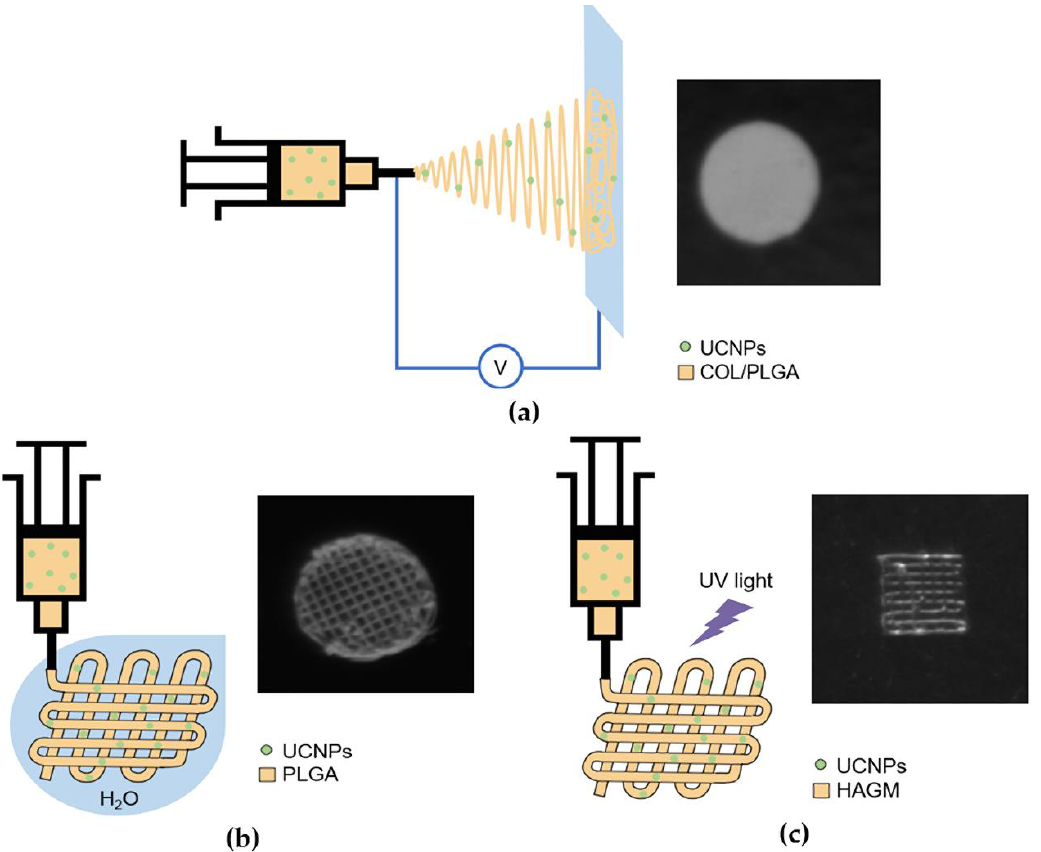
Figure 5. Schematic illustration of custom-build experimental setup for ( a ) electrospinning of polymer solutions; ( b ) anti-solvent extrusion 3D printing; ( c ) extrusion 3D printing with simultaneous photocuring and corresponding photoluminescent imaging of